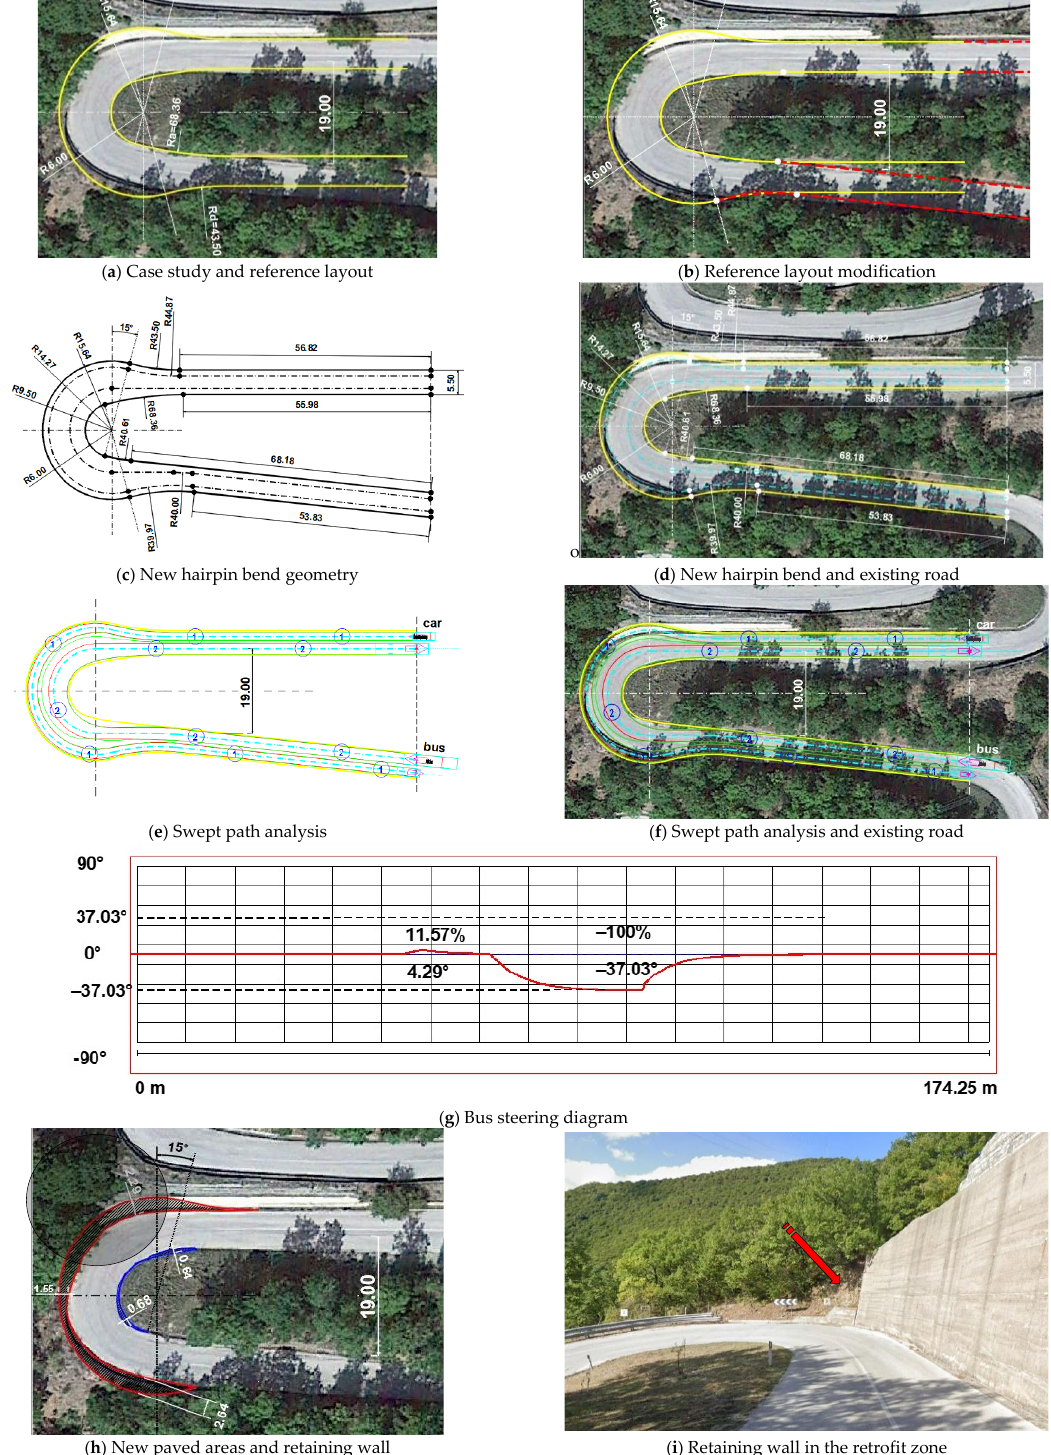
Figure 10. Case study (hairpin bend n.